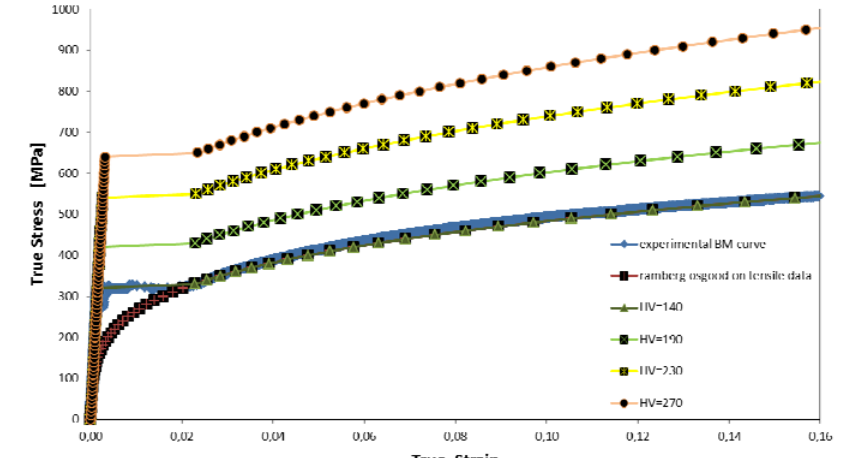
Figure 6: True stress-strain curve depending on hardness